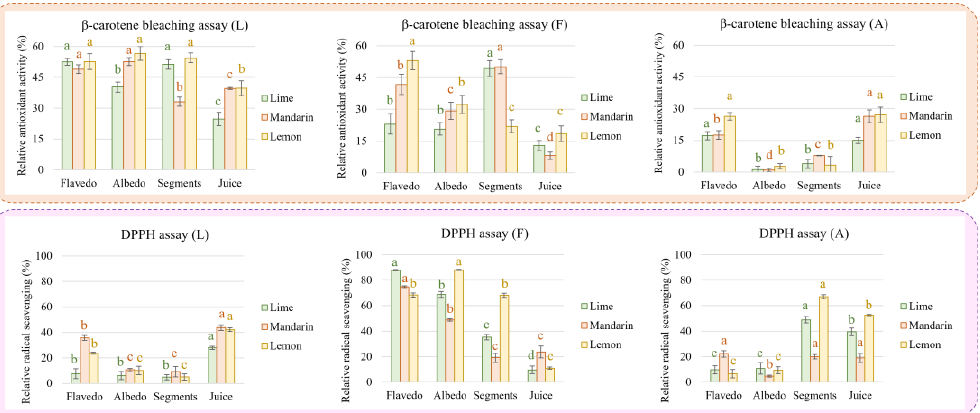
Figure 5. Antioxidant activity (β-carotene bleaching assay) and radical scavenging potential (DDPH assay) measured in fractions enriched in limonoids (L), flavonoids (F), and carboxylic acids (A) obtained by separation of extracts from citrus fruits. Different letters for the same fruit and fraction indicate significant differences in antioxidant or radical scavenging activity.